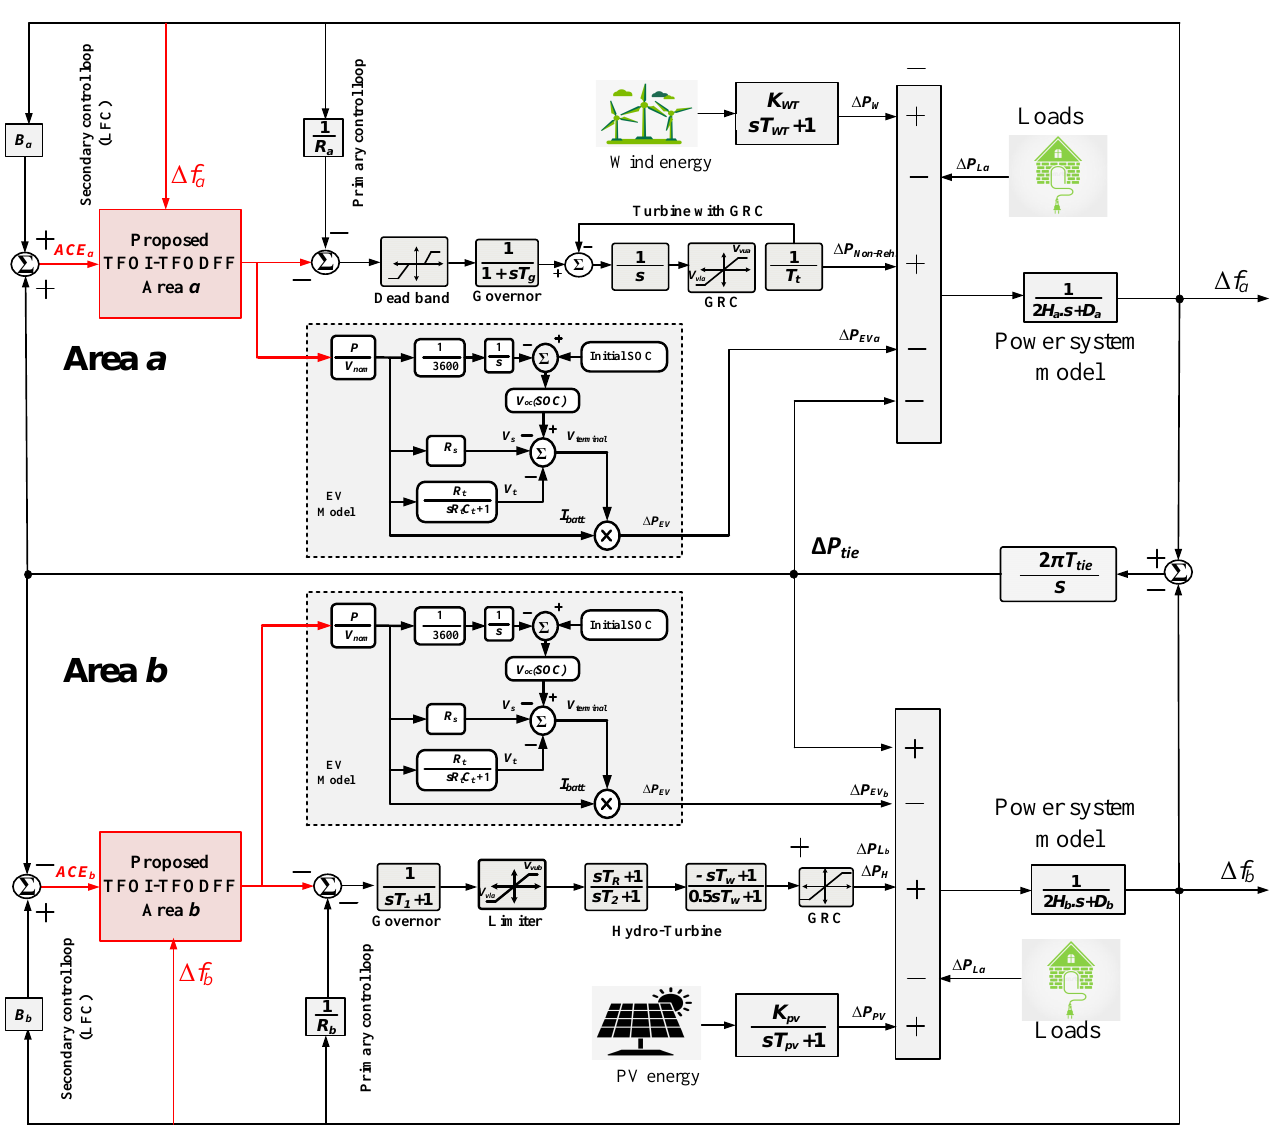
Figure 2. Mathematical representation models of selected power grid and the proposed TFOI- TFODFF